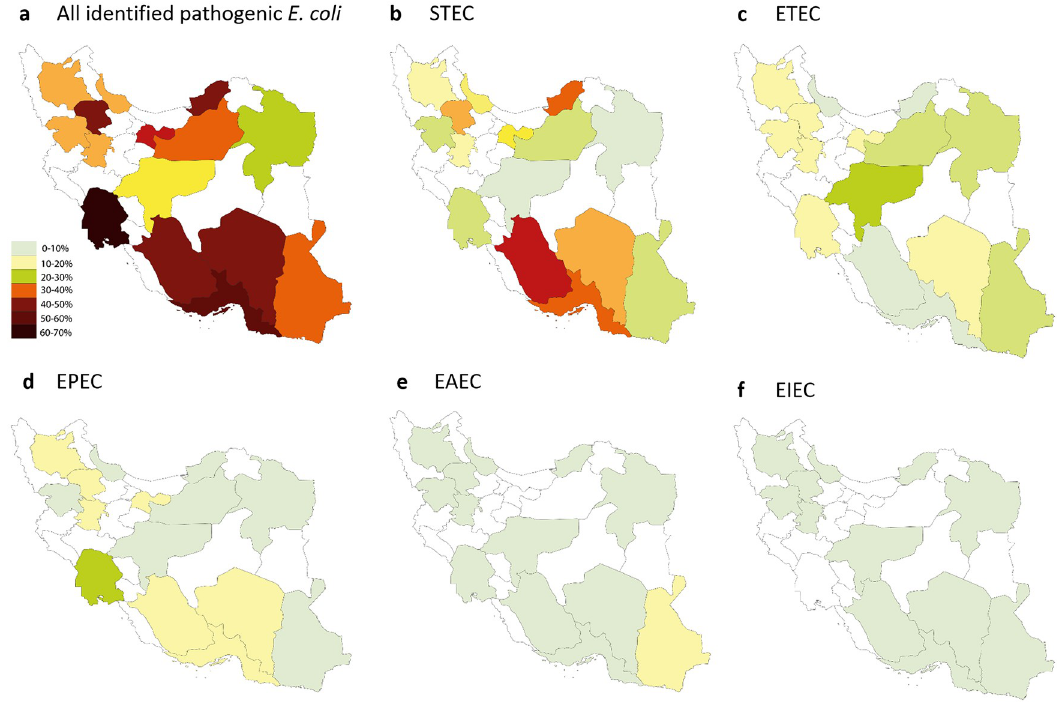
Fig 1. Frequency of E . coli pathotypes in 979 E . coli -positive culture samples collected from 15 provinces of Iran.